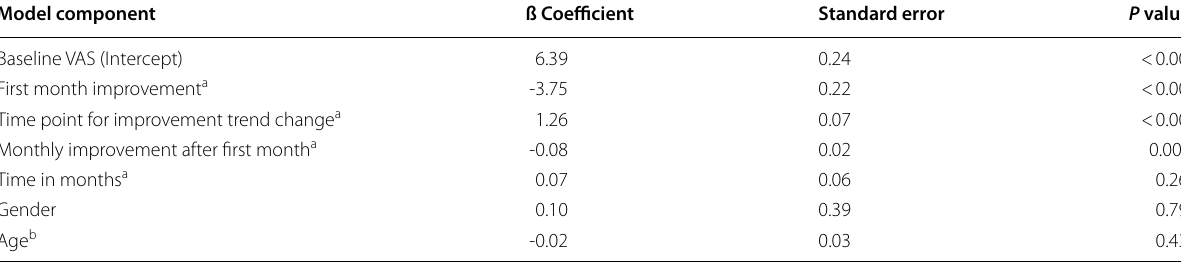
Table 2 Hierarchical Lineal Modeling for VAS maximum pain